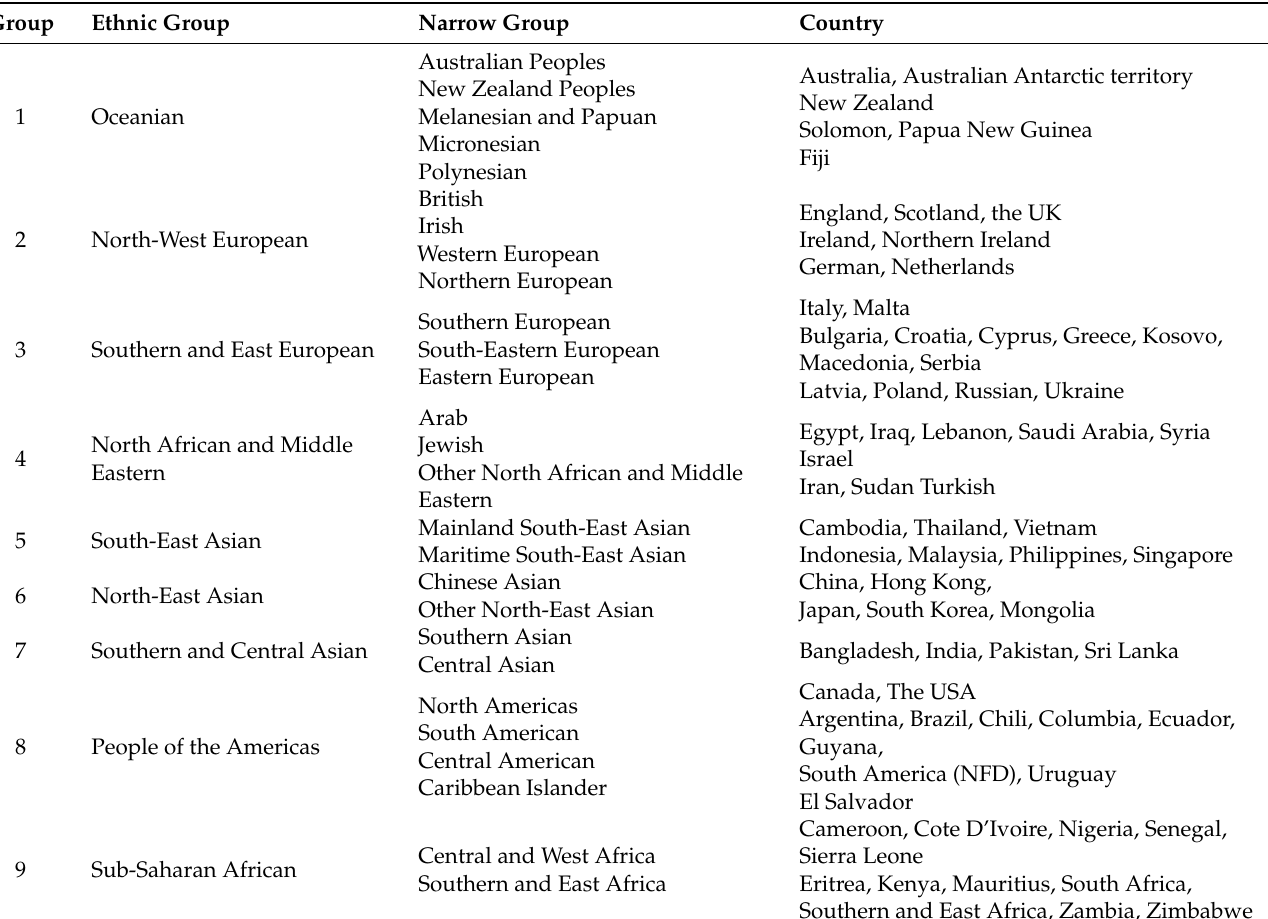
Table 1. Classification of countries and ethnic groups based on the Australian Standard Classification of Cultural and Ethnic